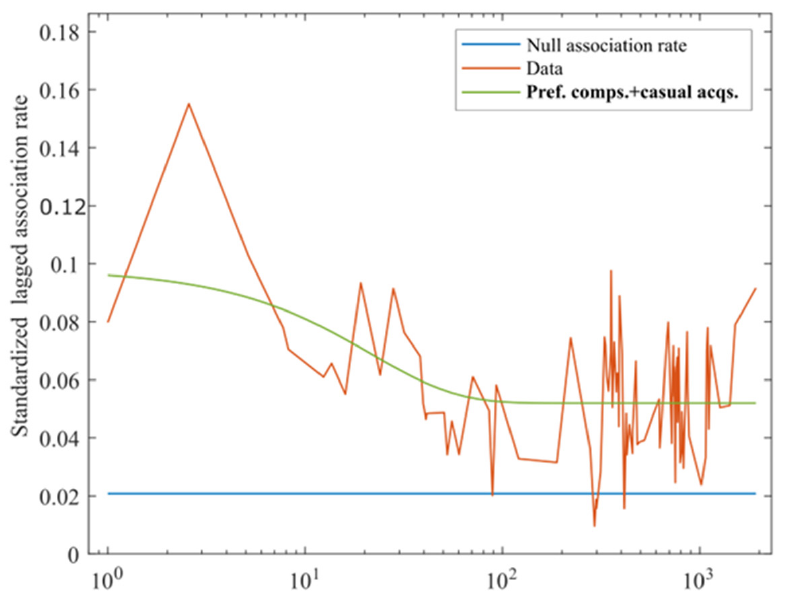
Figure 7. Standardized lagged association rates (SLARs) of bottlenose dolphins sighted at least three times in the Gulf of Taranto. The observed SLAR is represented by the dark orange line, the null association rate is the blue line. Table 5. Models fitted to LIR data of Gulf of Taranto. The model that best fit the data according to QAIC is shown in bold. ∆ QAIC indicates how well the data supports the less favored models [17]. Function